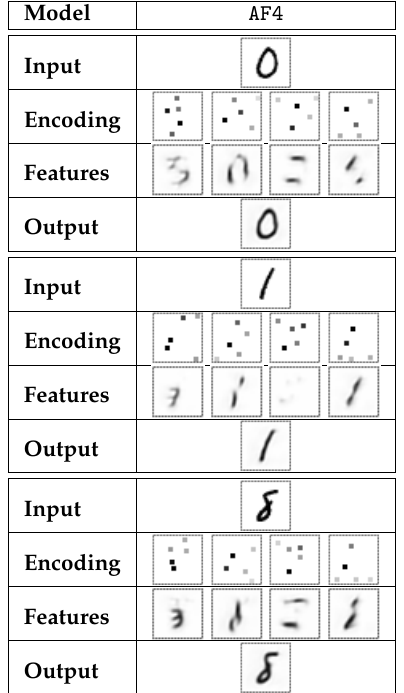
Figure 9. Sample encoding of selected digits performed by AF4 model. Highly sparse encoding (up to 5 non-zero elements in each encoding matrix) was used. Feature-specific decodings are presented, similar to those in Figure 8.